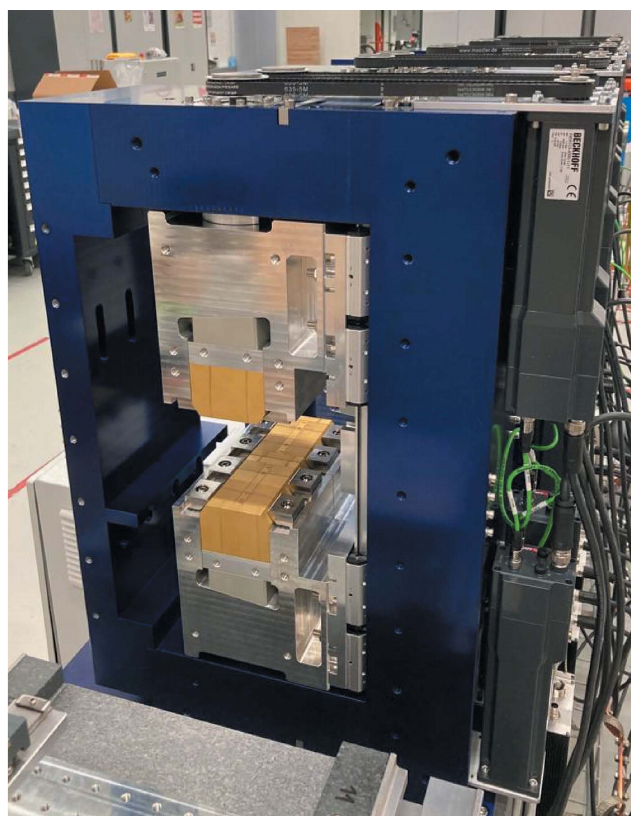
Figure 4 One magnetic period representing the mechanical unit of the modulator. In yellow are the magnets coated with TiN, on the right are the motors equipped with encoder and driving electronics, on the top is the gearbox made with a rubber chain, with a ratio of